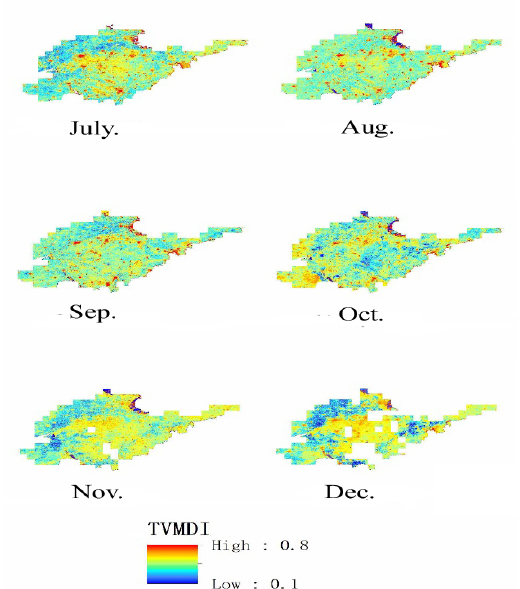
Fig.5 improved TVMDI figure of each month in Shandong